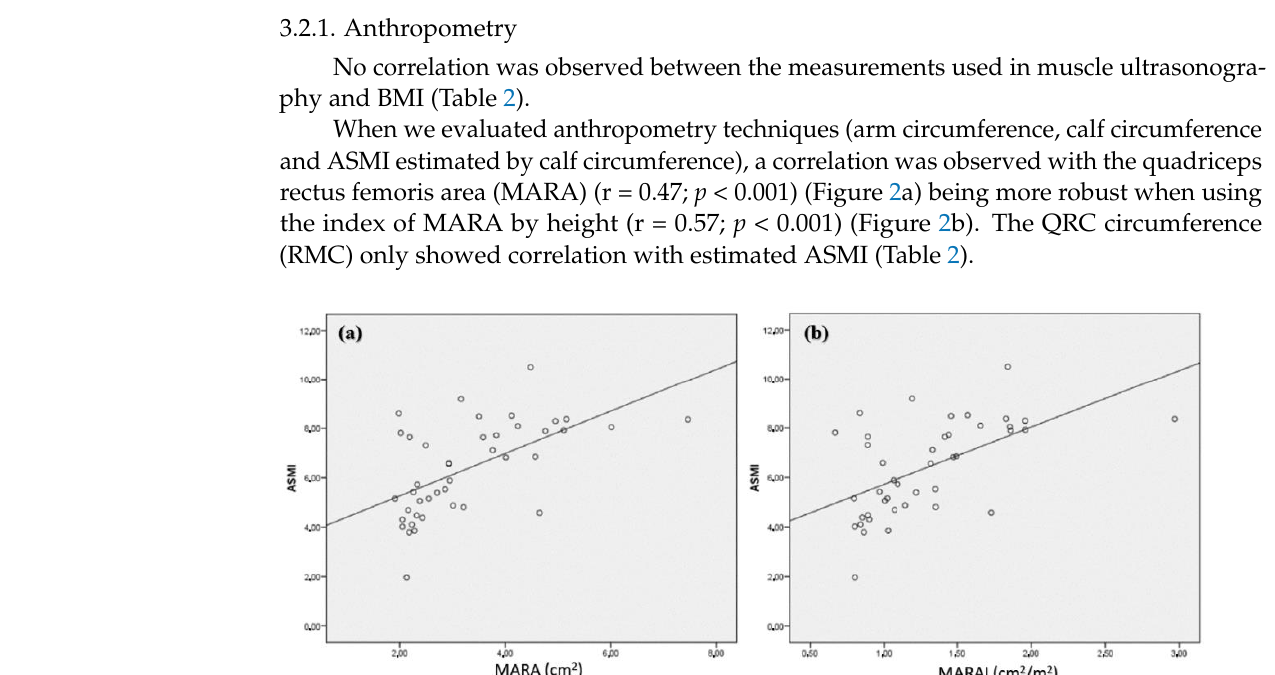
Figure 3. Correlation between phase angle ( a , b ) and electrical resistance ( c , d ) with MARA ( a , c ) and MARAI ( b , d ). MARA: muscular area rectus anterior, MARAI: muscular area rectus anterior index. A correlation of the FFMI with the muscle area (r = 0.48; p < 0.001) (Figure 4a) and circumference (r = 0.45; p < 0.001) (Figure 4b) measured by ultrasonography was observed. Likewise, a negative correlation was observed between the subcutaneous adipose tissue of muscle mass and a correlation with the muscular adipose index estimated by ultraso- nography (Table 2).